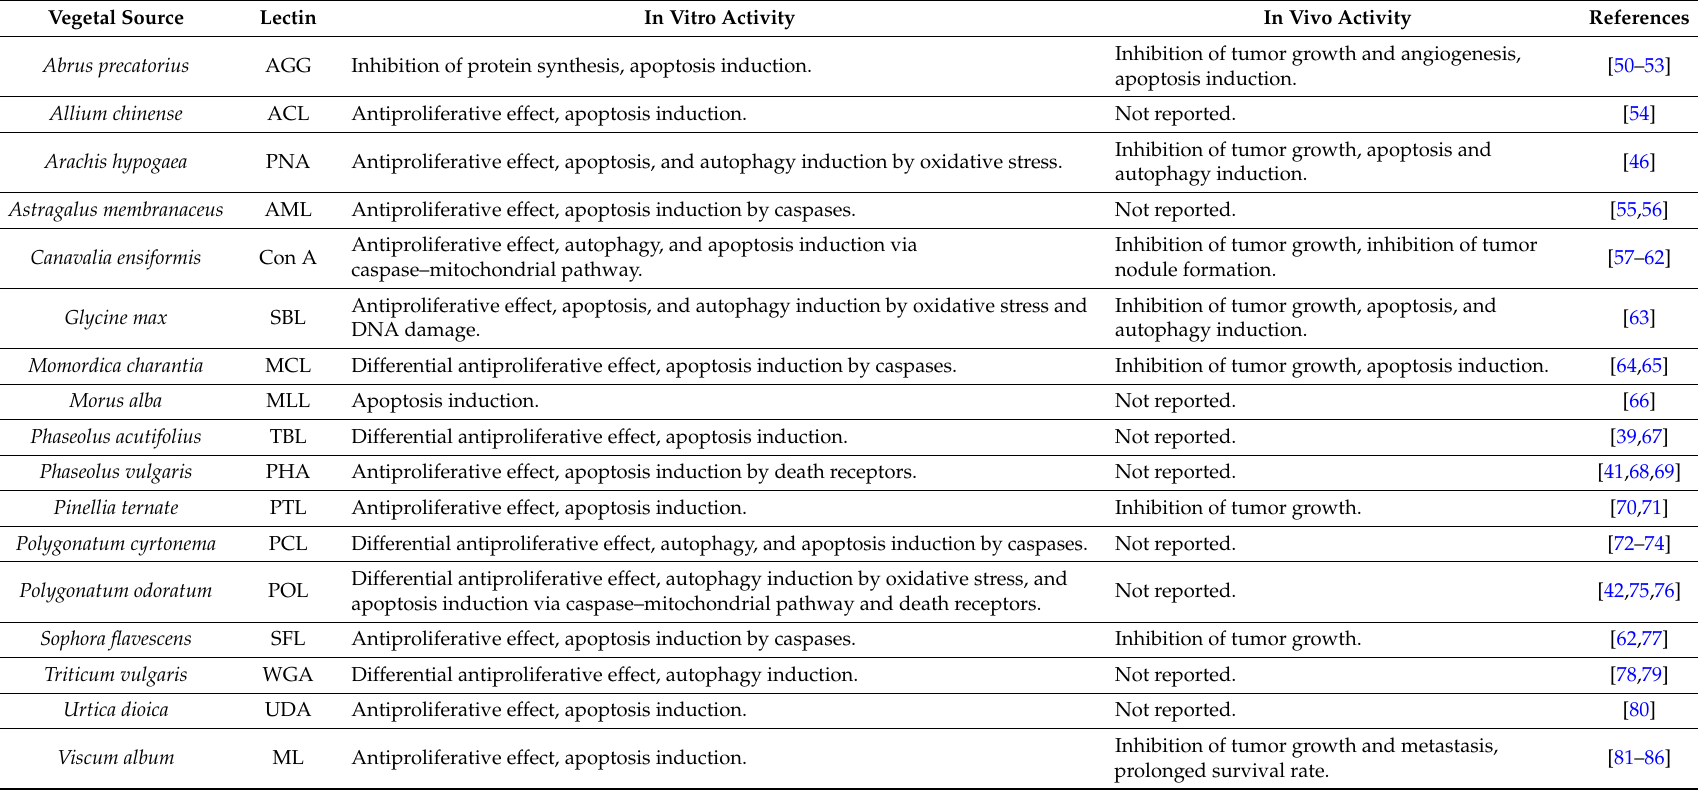
Table 1. Antineoplastic activity of plant